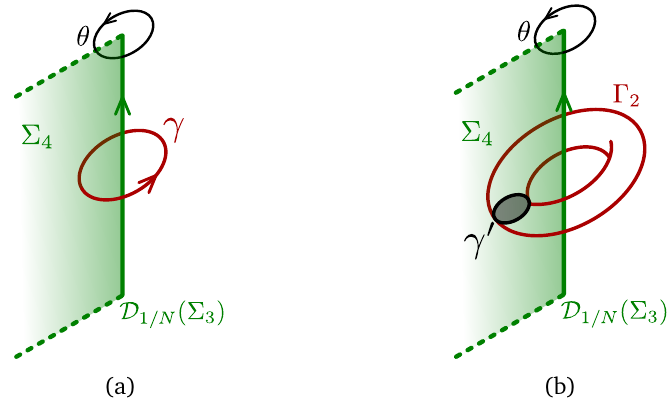
generating a 1 / N